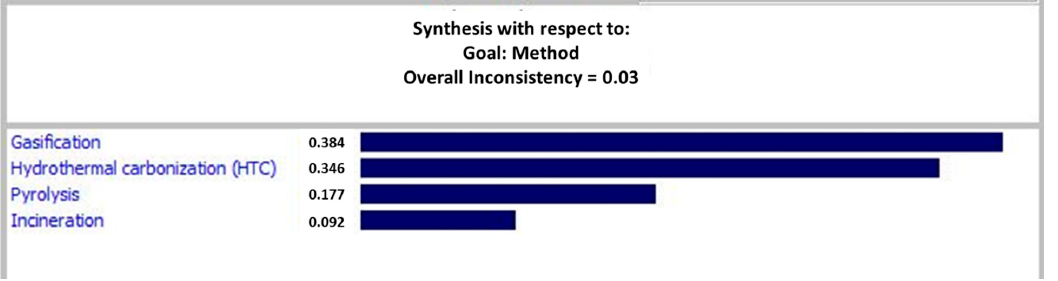
Figure 5. Final results of the AHP method in Expert Choice.